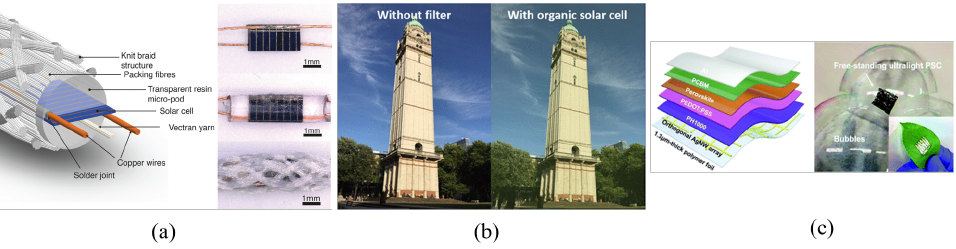
Figure 9. ( a ) Solar cell embedded into yarns (Reprinted from [97] under CC BY 4.0 license); ( b ) Trans- parent organic solar cell (Reprinted with permission from [93]. Copyright 2020 American Chemical Society); ( c ) Flexible perovskite solar cell (Reprinted with permission [94]. Copyright 2019 Royal Society of